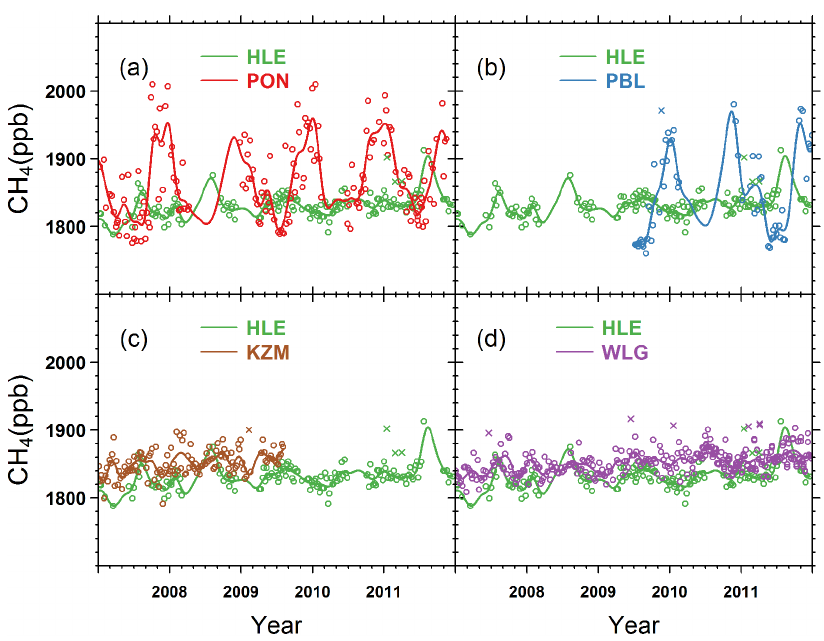
Figure 4. Time series of CH 4 flask measurements at (a) HLE and PON, (b) HLE and PBL, (c) HLE and KZM, and (d) HLE and WLG. The open circles denote flask data used to fit the smoothed curves, while the crosses denote discarded flask data lying outside 3 times the residual standard deviations from the smoothed curve fits. For each station, the smoothed curve is fitted using Thoning’s method (Thoning et al., 1989) after removing